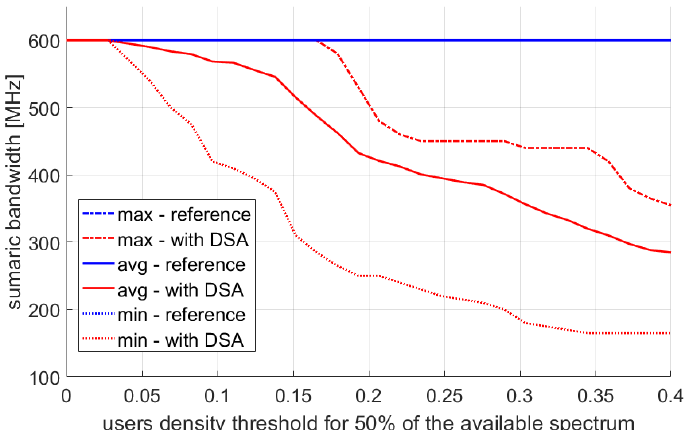
Figure 11. Total frequency band used in the